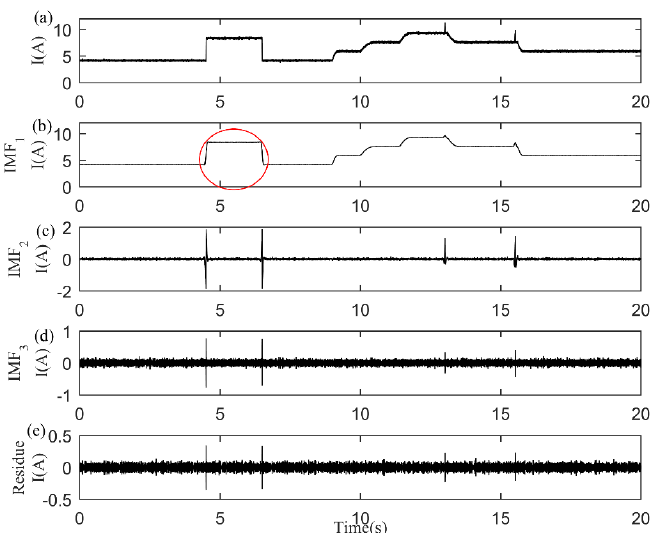
Figure 21. VMD decomposition diagram of the experimental signal. ( a ) Experimental current sig- nal; ( b ) IMF 1 component; ( c ) IMF 2 component; ( d ) IMF 3 component; ( e ) Residue.